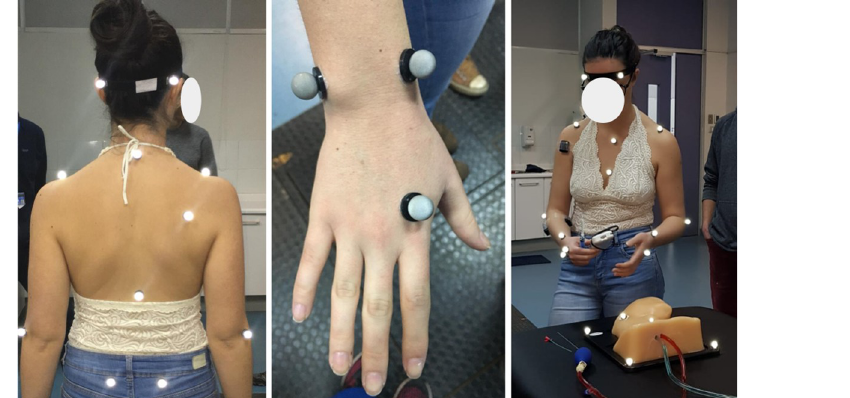
Fig 2. Placement of markers on the subject.